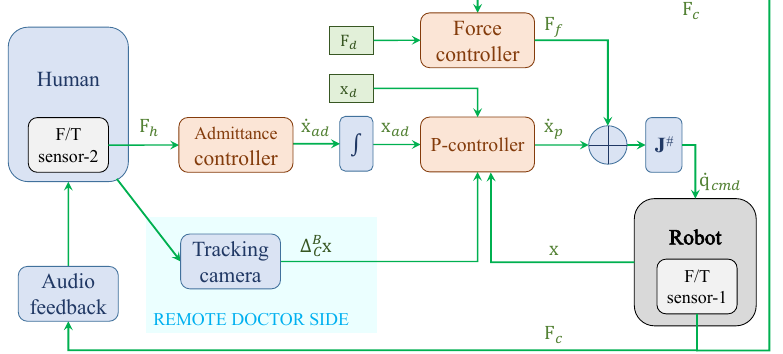
Figure 2. Block diagram of the proposed dual-mode p HRI- tele HRI control system with a custom hybrid admittance-force controller. F c represents the probe–tissue contact force measured by sensor-1, F h represents the external human force measured by sensor-2, F f represents the output of the force controller, ˙x p represents the generated Cartesian velocity from the P-controller, x represents the actual pose of the robot EE in Cartesian space, J # represents the pseudoinverse of the Jacobian matrix, and ˙q cmd represents the joint velocity command sent to the